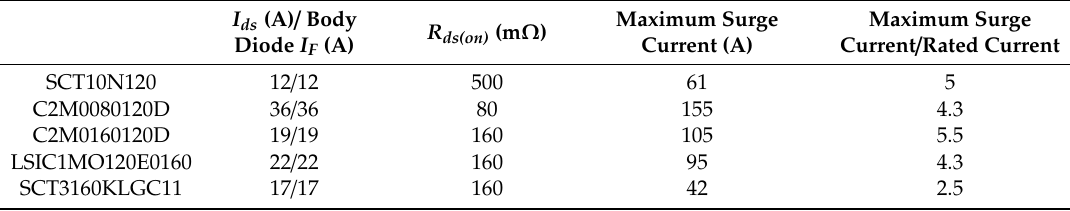
Table 3. Maximum surge current that a device can